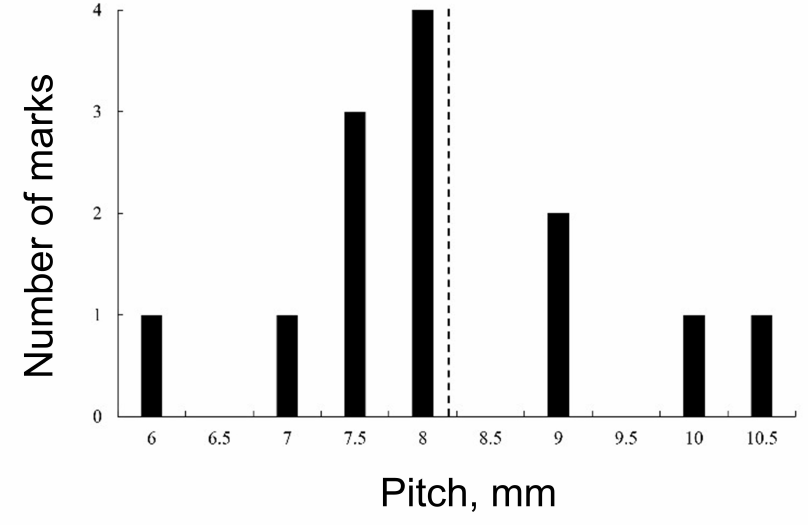
Figure 12. Experimental results showing the number of marks associated with a given pitch, taken from [30]. The vertical dashed line shows the average